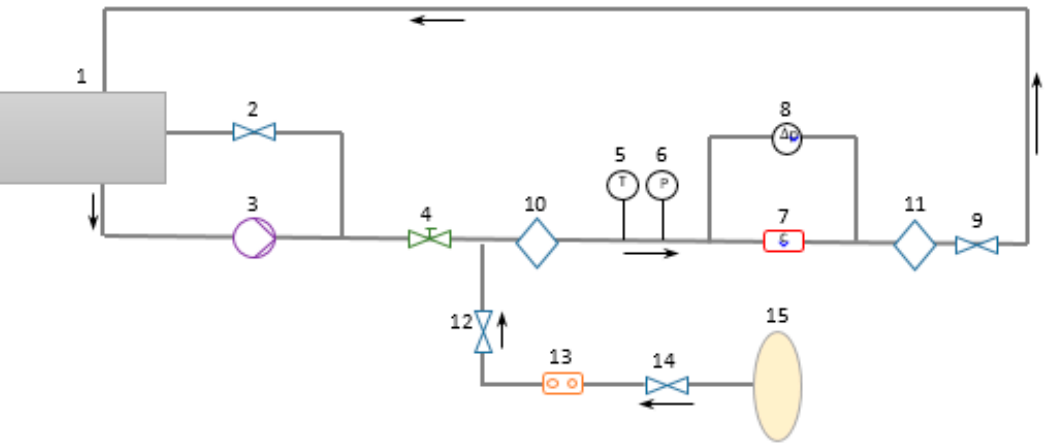
Figure 2. The experimental setup scheme. 1—water tank, 2—by-pass valve; 3—water pump; 4—